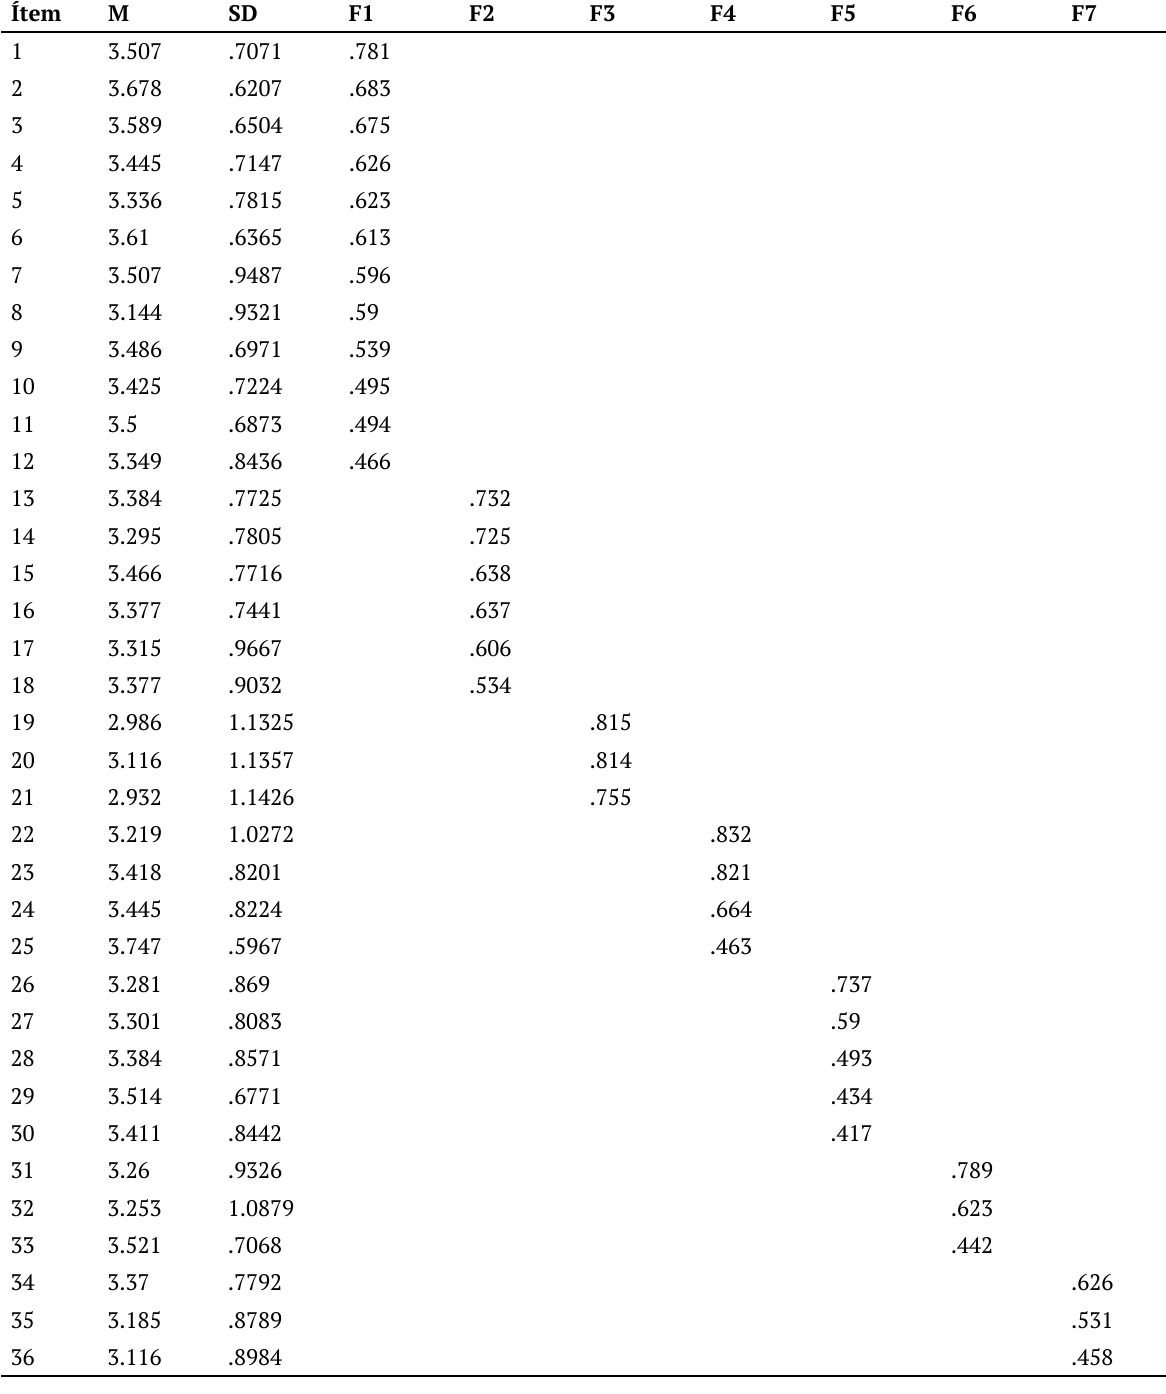
Table 2. Matrix of rotated components of the factorial analysis